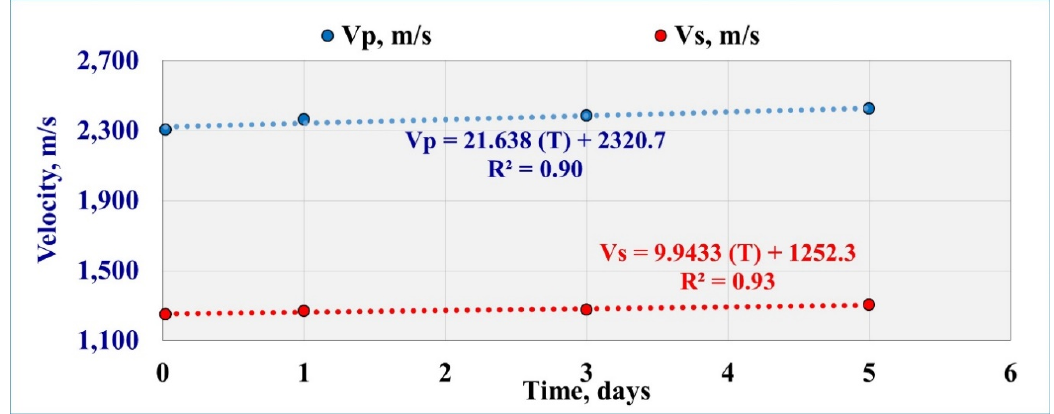
Figure 3. Sonic measurements after the filtration test with different exposure time.